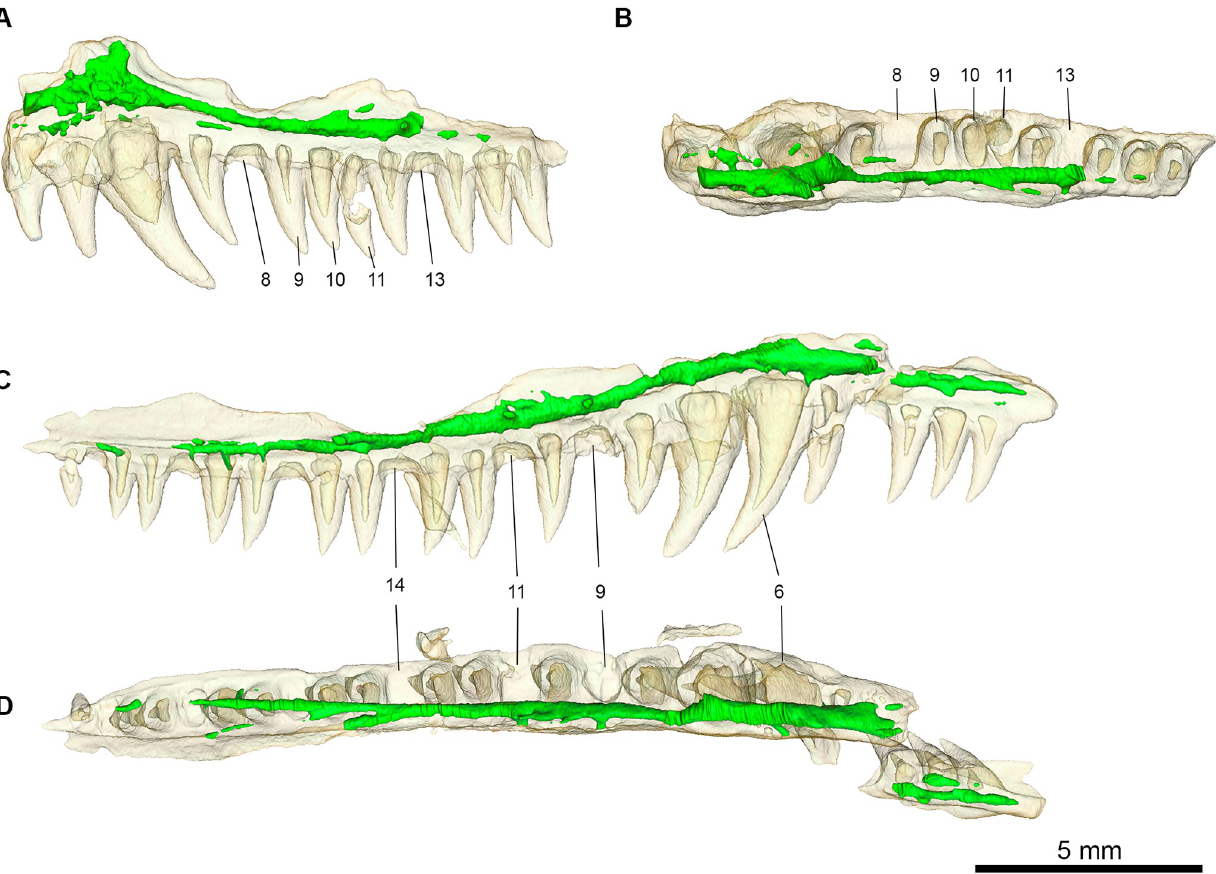
Fig 3. Rendering of maxillary innervation from CT imaging sequences of Maiothisavros dianeae (ROMVP 87366). Innervation shown in green for (A) left maxilla in lateral view and (B) and dorsal view, (C) right maxilla in lateral view and (D) dorsal view.